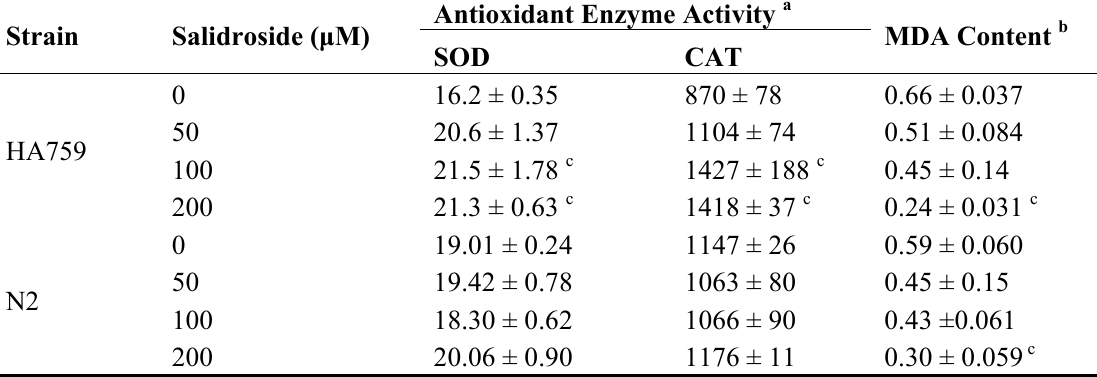
Table 1. Effect of salidroside on the activity of antioxidant enzymes and malondialdehyde content in C. elegans